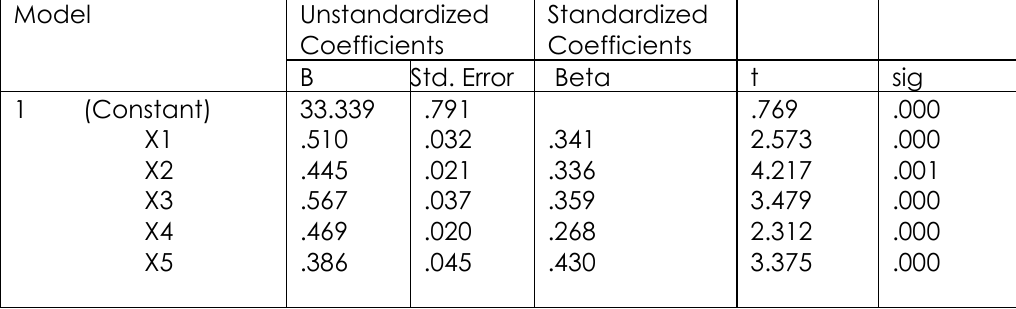
Table.3: Analisis Multiple Regression